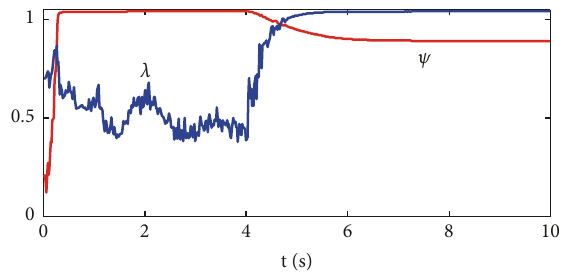
Figure 4: The polarization index and differentiation index in the fusion-fission process.